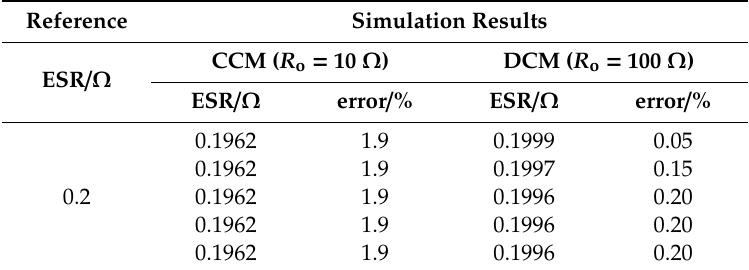
Table 3. ESR Simulation Results of Buck Converter by Method 2.